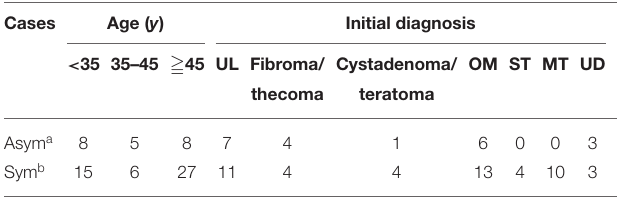
TABLE 3 | Age distribution and preoperative diagnosis of ovarian leiomyoma.